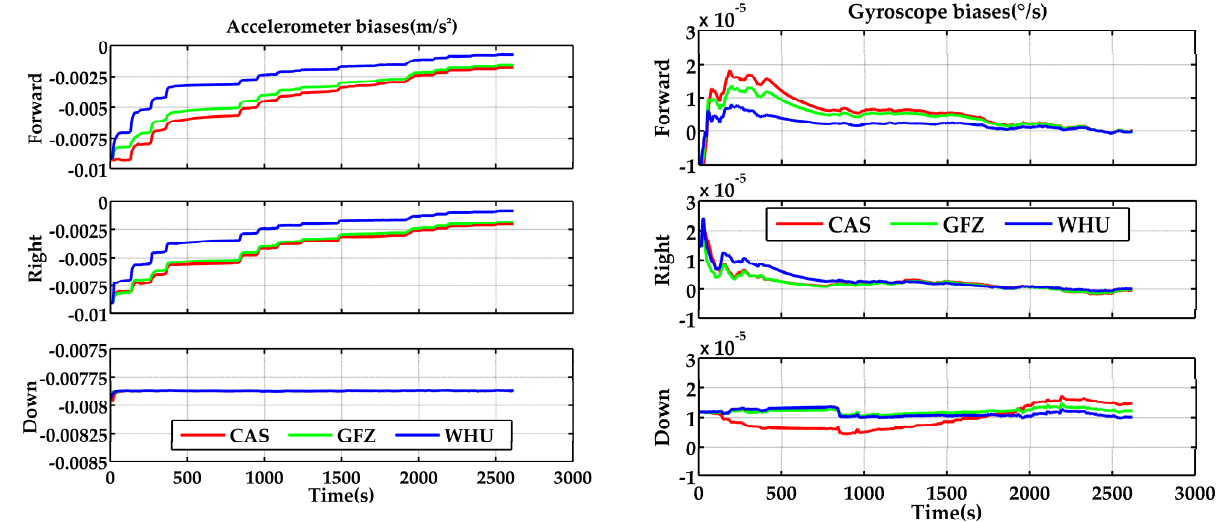
Figure 14. Accelerometer ( left ) and gyroscope ( right ) biases and scale factors in the body frame (Forward–Right–Down) by utilizing real-time products from CAS, GFZ, and WHU (the start time is 195,453 s).